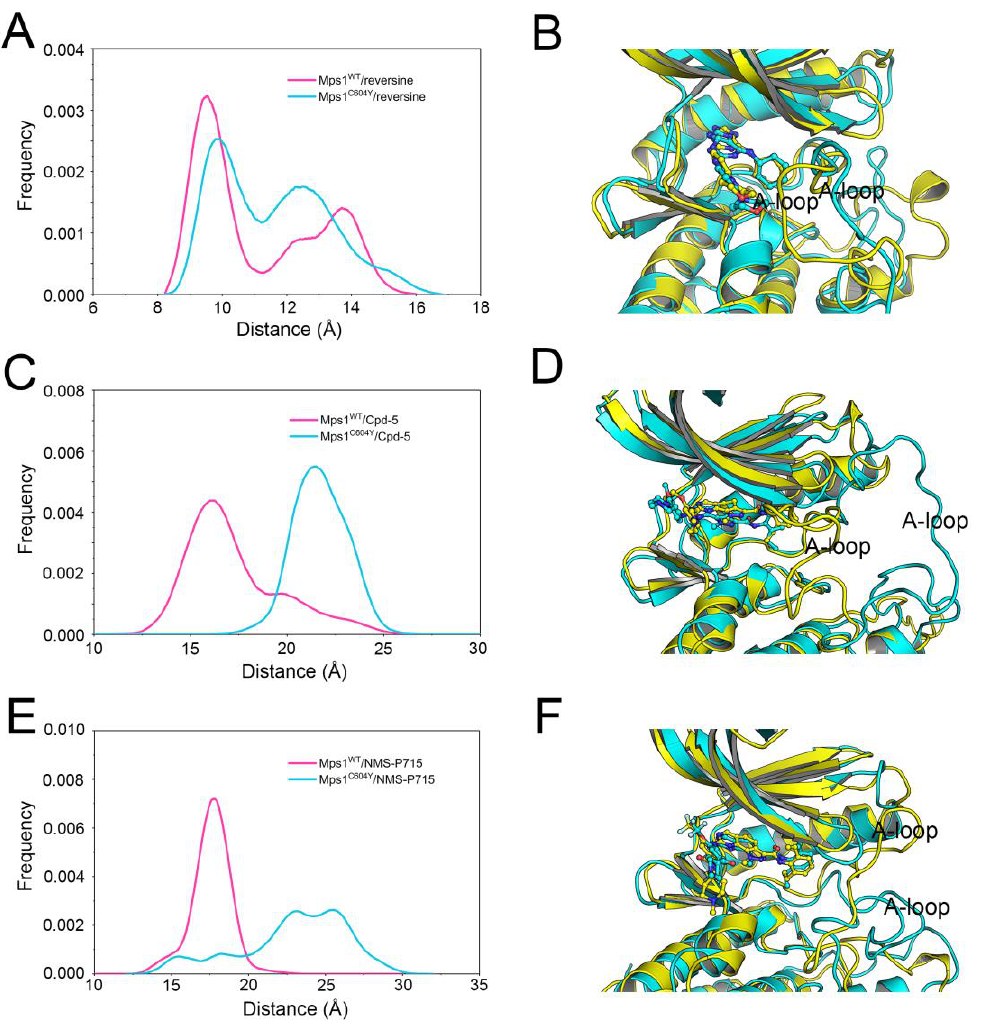
Figure 4. The distribution of the opening degree of the A-loop and alignment of the most populated between Mps1 WT and Mps1 C604Y . The opening degree was defined as the center of mass of the A-loop to the center of mass of the inhibitor. The distribution of the opening degree of the A-loop between ( A ) Mps1 WT /reversine and Mps1 C604Y /reversine, ( C ) Mps1 WT /Cpd-5 and Mps1 C604Y /Cpd-5, ( E ) Mps1 WT /NMS-P715 and Mps1 C604Y /NMS-P715. Alignment of the most populated conformations between ( B ) Mps1 WT /reversine and Mps1 C604Y /reversine, ( D ) Mps1 WT /Cpd-5 and Mps1 C604Y /Cpd-5, ( F ) Mps1 WT /NMS-P715 and Mps1 C604Y /NMS-P715.